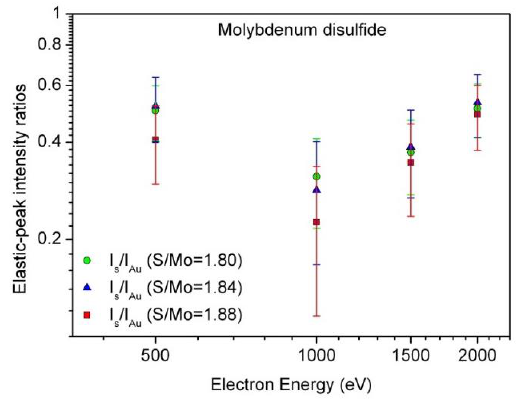
Figure 3. Energy dependence of the measured elastic-peak intensity ratios, I s / I Au , recorded from molybdenum disulfide surfaces with increasing S/Mo AC ratio: S/Mo = 1.80 (open circles); S/Mo = 1.84 (open triangles); S/Mo = 1.88 (open squares), and gold surfaces (α in = 0°, α out = 60° measured from the surface normal). Error bars for the I s / I Au ratios represent one standard deviation.